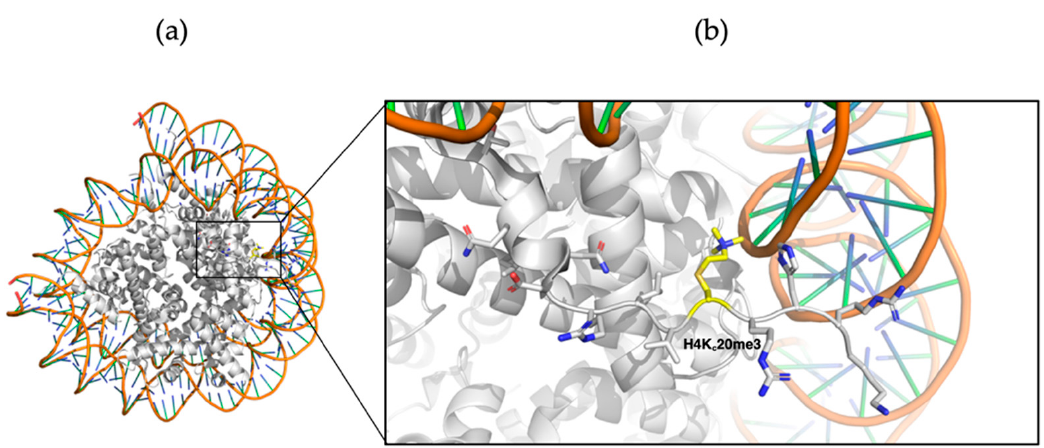
Figure 18. ( a ) Ribbon representations of the nucleosome assembly, showing the histone octamer (grey) in complex with DNA (orange). The K c me3 residue on histone 4 is shown in yellow (PDB-ID: 3C1B). ( b ) A zoomed view on H4K c 20me3 pointing towards the DNA.